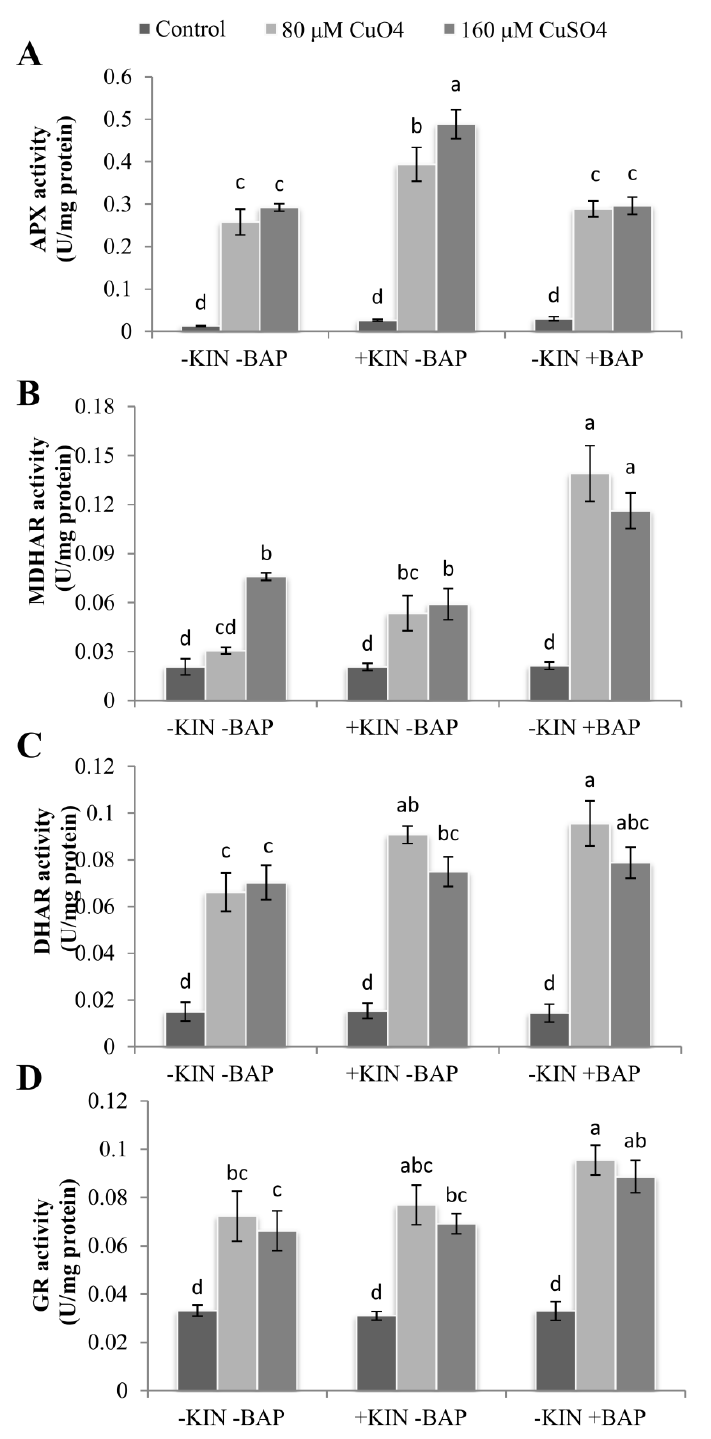
Figure 7. APX ( A ), MDHAR ( B ), DHAR ( C ), and GR ( D ) activities in the cotyledonary leaves of R. communis after 6 day of exposure to CuSO 4 (80 and 160 µM) and cytokinin (KIN and BAP) treatments in Hoagland’s nutrient medium. Values are the mean ± SE of three independent experiments. Different alphabetical letters indicate significant differences between treatments according to one-way ANOVA (Duncan’s test p ≤ 0.05).